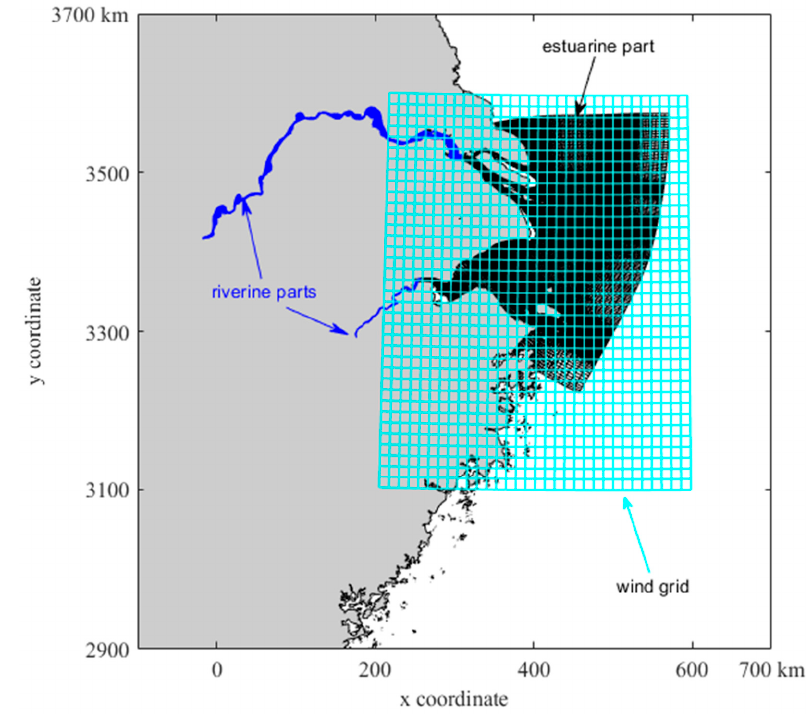
Figure 3. Grids of the reanalysis wind data and hydrodynamic model. The daily mean discharge at Datong station and the monthly mean discharge at Lucipu station were provided as upstream boundary conditions. Tidal evaluation at open boundaries is represented by the mean sea level and 13 tidal constituents (M2, S2, N2, K2, K1, O1, P1, Q1, M.F., MM, M4, MS4, and MN4). The wind data used in the model were derived from ERA-interim data, and the wind was only applied to the sea domain. The bed friction coefficient is a key parameter that determines the bed shear stress and the distribution of the velocity field. The Manning coefficient was chosen to represent the bottom roughness in the model. A value of 0.019 s/m 1/3 was applied in the riverine part, and 0.011 s/m 1/3 was used in the estuarine part. The computational time step was selected as 1 min. 3. Results 3.1. Modified Single Station’s Wind Data Figure 4 shows the comparison between measured and reanalysis wind speeds for the year 2014 in different directions at the four wind stations. The root mean square error at each station is within the range of 1.02–3.30 m/s, and the correlation coefficient, r, is within the range of 0.41–0.89. Therefore, high correlations between two types of wind data can be observed, confirming the feasibility of the linear regression method for wind modification.